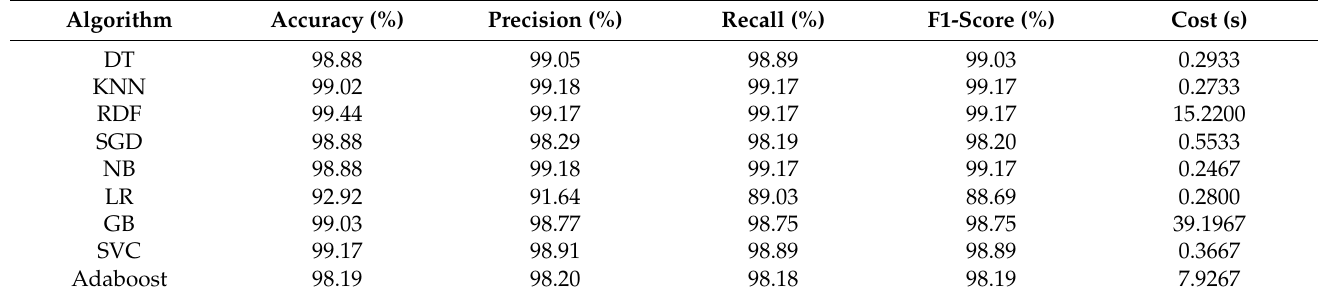
Table 9. Global performance comparison of ML models using impedance (Z)